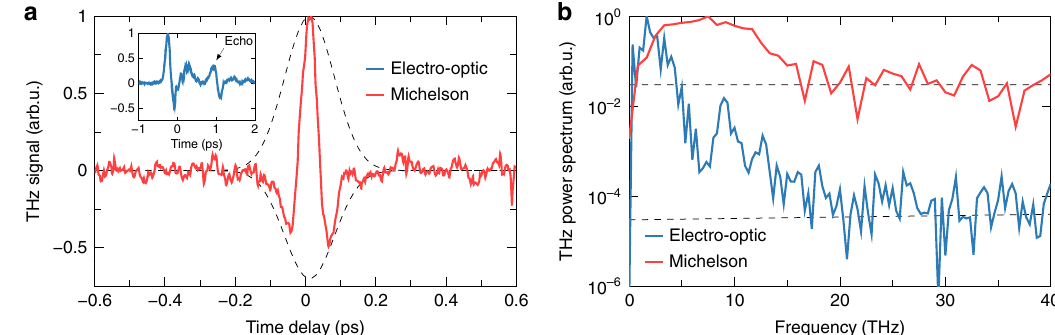
Fig. 4 THz fi eld and spectrum. a THz signals measured by electro-optic sampling (inset, blue) and by Michelson interferometer (red). b THz power spectra (solid lines) obtained by the above techniques together with the noise levels of each technique